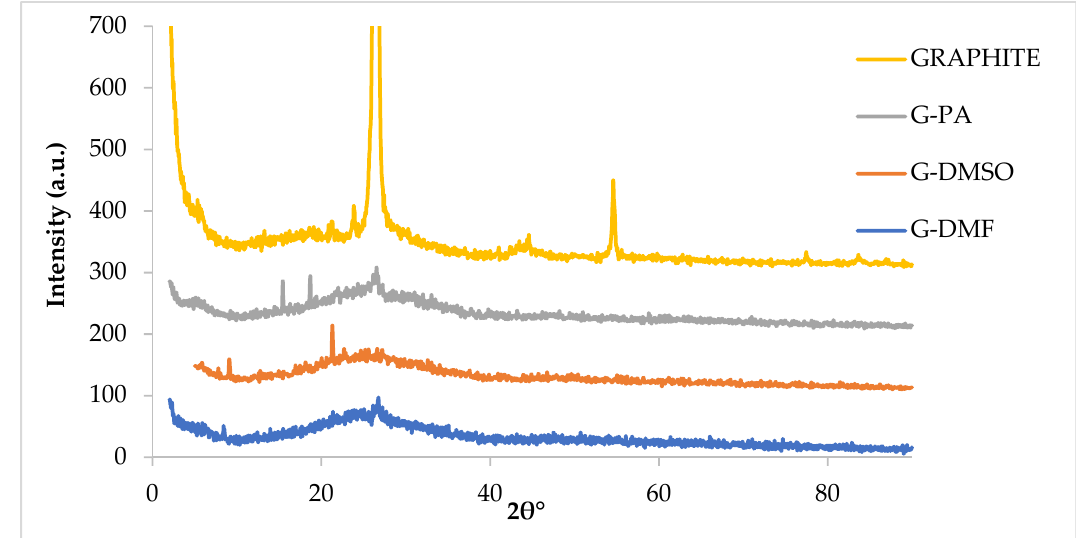
Figure 4. XRD results of synthesized graphene products.